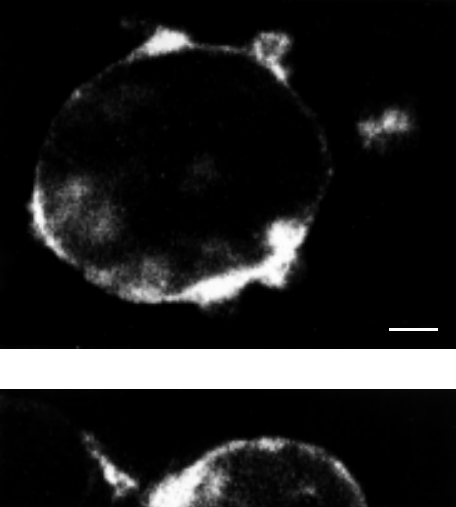
Figure 1 - Binding of fluo-NT to COS-7 cells transfected with c- DNA encoding the low-affinity NT receptor (NT-2). Cells were incubated for 30 min, at 4 o C, in the presence of 10 nM fluo-NT. Labeling is strictly membrane- bound and forms a more or less homogeneous pericellular ring. Scale bar: 5 µm.